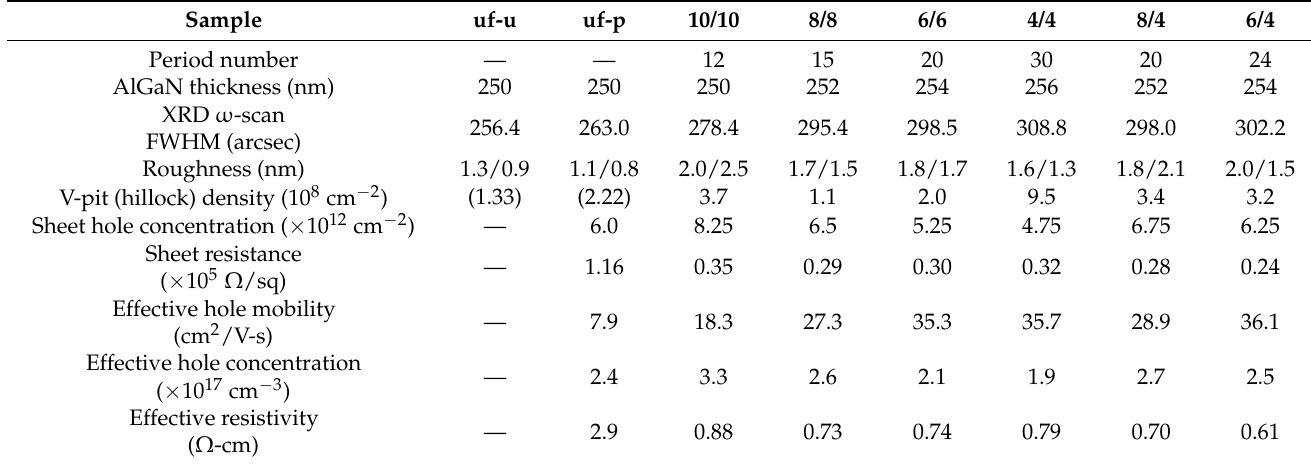
Table 1. Structures and characterization results of the samples under